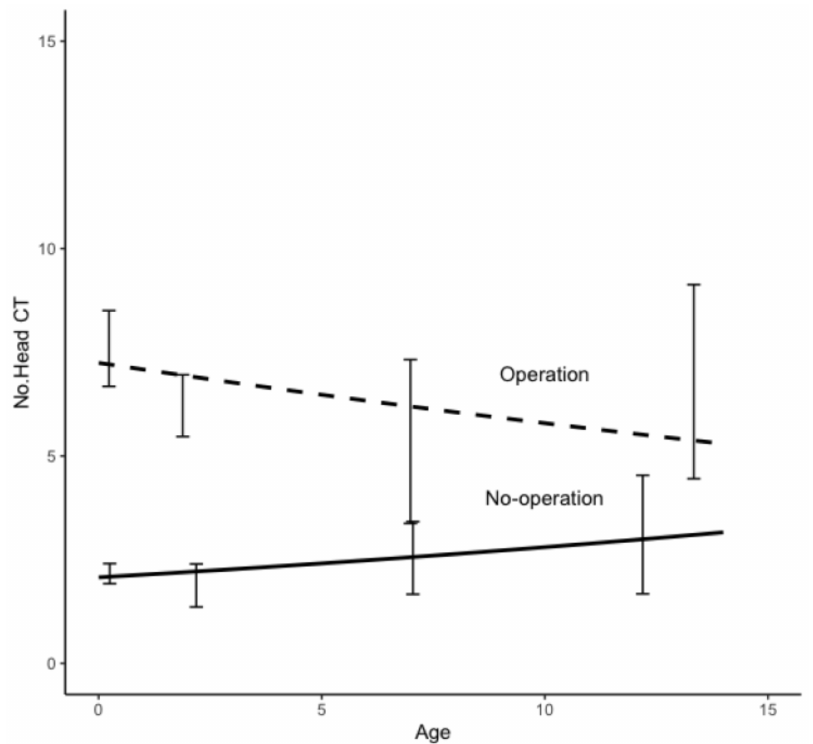
Figure 4. Age dependence of the number of CT examinations in patients with congenital anomalies with and without surgery. The age is at the time of initial